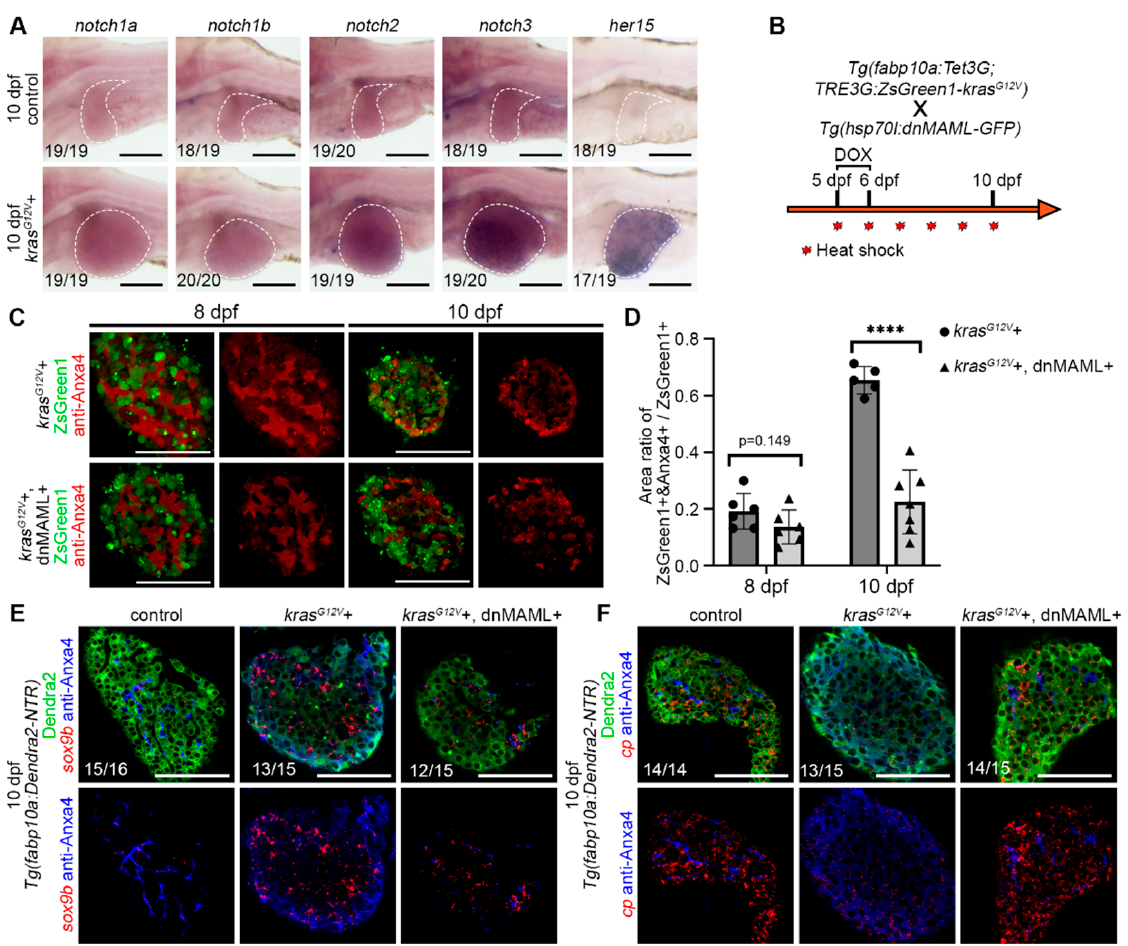
Figure 3. The Notch signaling pathway was upregulated after hepatocellular carcinoma induction, and the inhibition of Notch signaling suppressed hepatocyte dedifferentiation. ( A ) WISH results showed the expression pattern of notch1a , notch1b , notch2 , notch3 , and her15 at 10 dpf after DOX activation of kras G12V . ( B ) Tg(fabp10a:Tet3G;TRE3G:kras G12V -ZsGreen1) with Tg(Hsp70l:dnMAML-GFP) double transgenic fish line treatment strategy. ( C ) Monolayer images of Anxa4 antibody staining showed expression changes in the DOX-induced kras G12V + and kras G12V + and dnMAML+ groups at 8 dpf and 10 dpf. ( D ) Statistics of Anxa4 + and ZsGreen1 + /ZsGreen1+ ratio in the DOX-induced kras G12V + ( n = 11) and kras G12V + and dnMAML+ ( n = 13) groups at 8 dpf and 10 dpf. ( E ) The results of fluorescent in situ hybridization (FISH) showed sox9b expression in the DOX-induced control and kras G12V + and kras G12V + and dnMAML+ groups at 10 dpf. ( F ) The results of FISH showed cp expression in the DOX-induced control, kras G12V + and kras G12V + and dnMAML+ groups at 10 dpf. Numbers indicate the proportion of larvae exhibiting that expression. Asterisks show significance: ****— p < 0.0001. Scale bars—100 μ m; error bars—S.D.